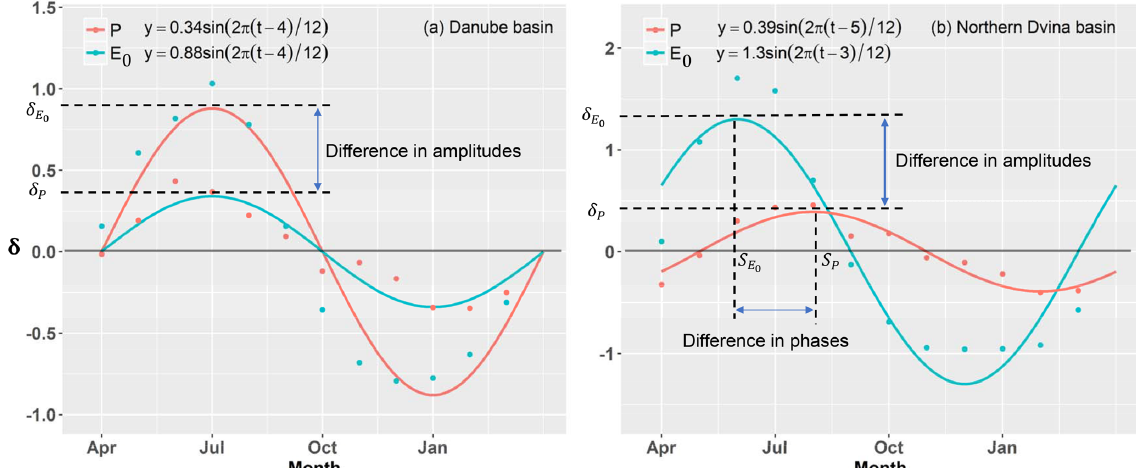
Figure 1. Two examples showing the mismatch between long-term monthly precipitation ( P ) and potential evapotranspiration ( E 0 ), in terms of (a) seasonal amplitudes ( δ P , δ E ) and (b) phase shift ( S P , S E 0 0